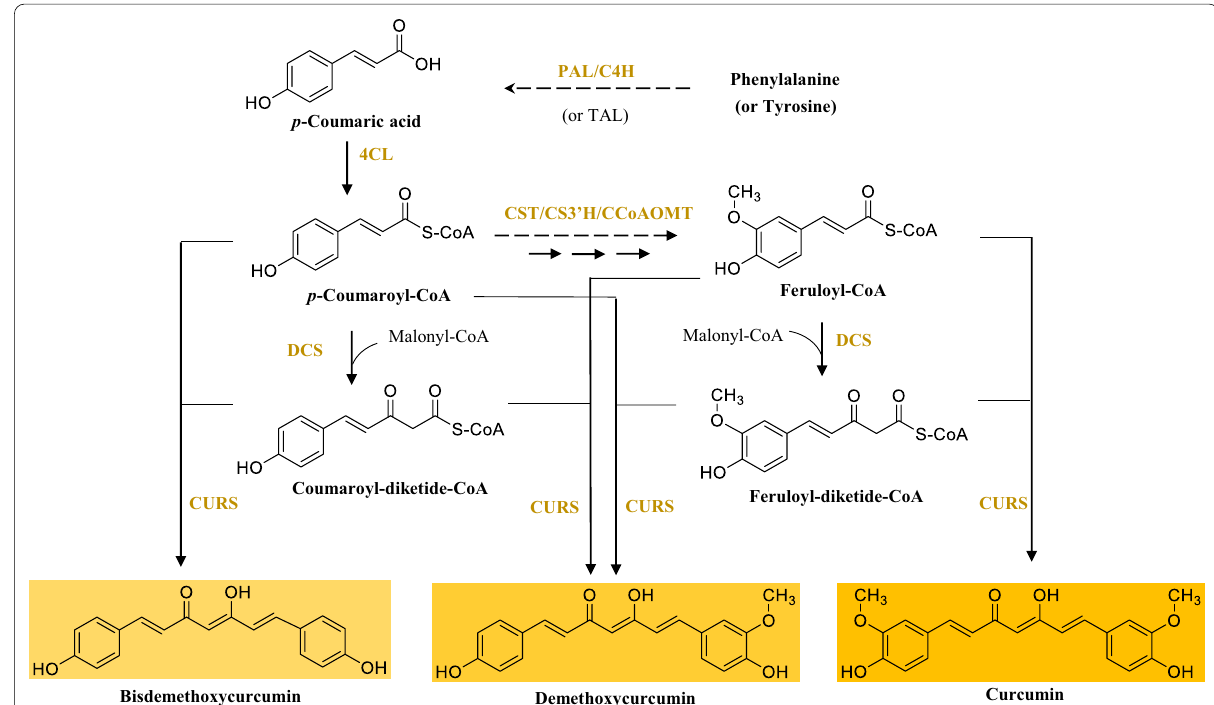
Fig. 10 Schematic of curcuminoids biosynthesis. DCS, diketide-CoA synthase; CST, coumaroyl shikimate transferase; CS3 ′ H, p -coumaroyl 5-O-shikimate 3 ′ -hydroxylase; CCoAOMT, caffeoyl-CoA O-methyltransferase; CURS, curcumin